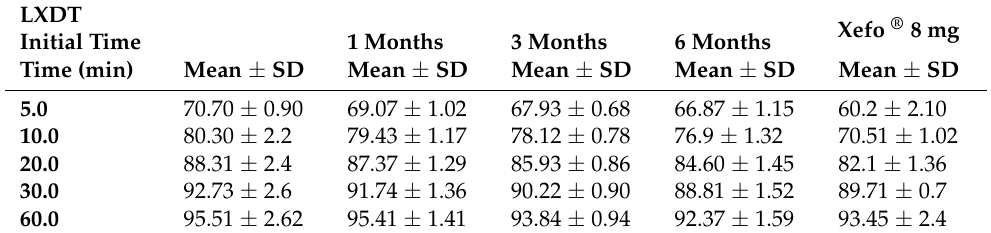
Table 7. In vitro dissolution study at different times during accelerated stability study.